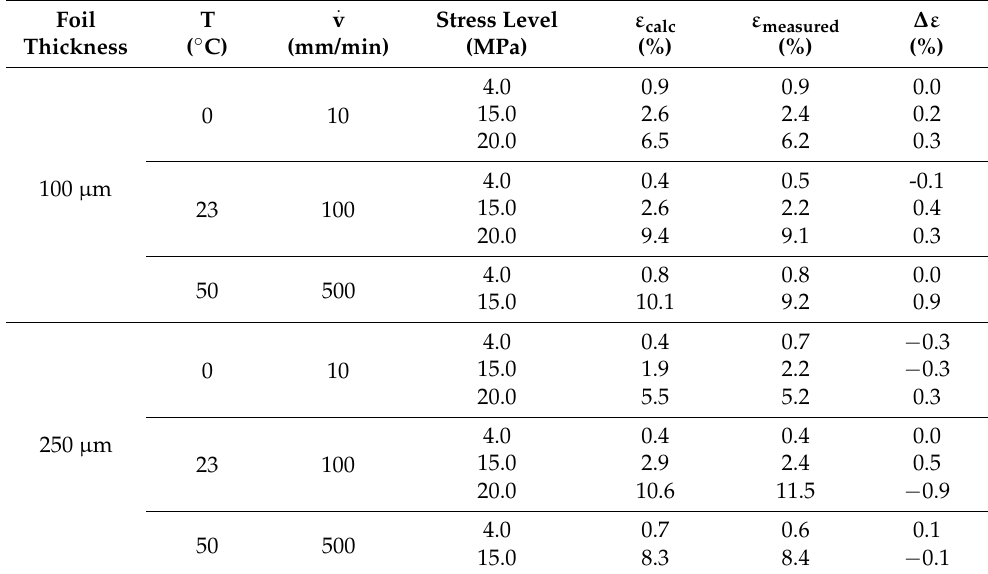
Table 6. Comparison of calculated strain using the derived material model versus 5% fractile strain of experimentally determined stress-strain paths of three different producers at specific